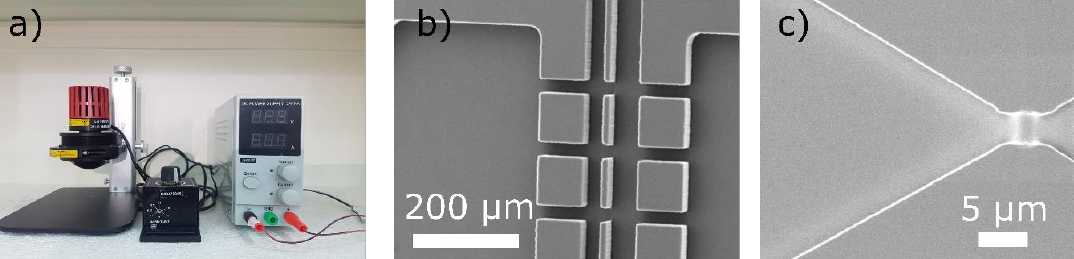
Figure 2. Low-cost photolithography set-up. ( a ) Ultraviolet light-emitting diode (UV LED) set-up at Universitas Indonesia, for single layer exposure. ( b ) Scanning electron microscope (SEM) micrograph of a polydimethylsiloxane (PDMS) microstructure replicated from a master mould (SU8 3025 on silicon wafer). ( c ) SEM micrograph of SU8 (2000.5) structures obtained using a chrome mask.